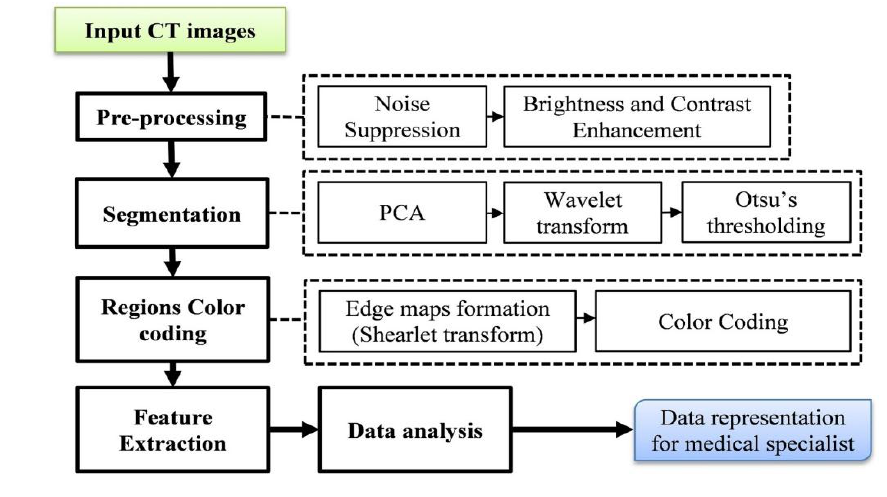
Figure 1 . Flow-chart of image processing.